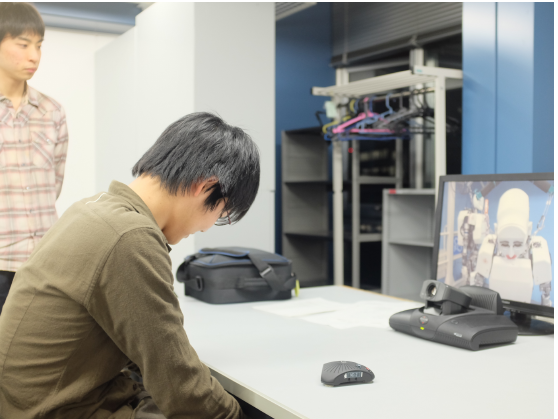
Figure 9. Successful moment of greeting interaction. Even for Japanese sub- jects, this happened